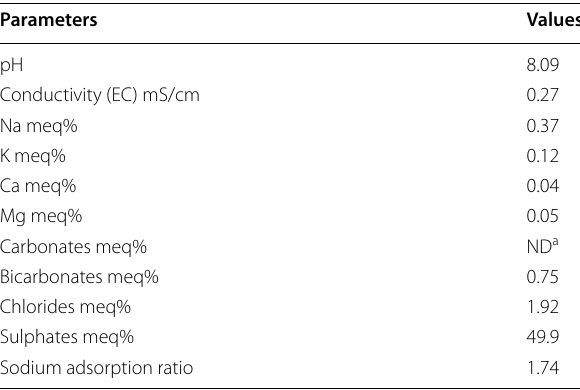
Table. 2 Soil chemical analyses of the experimental soils Soil depth (m)